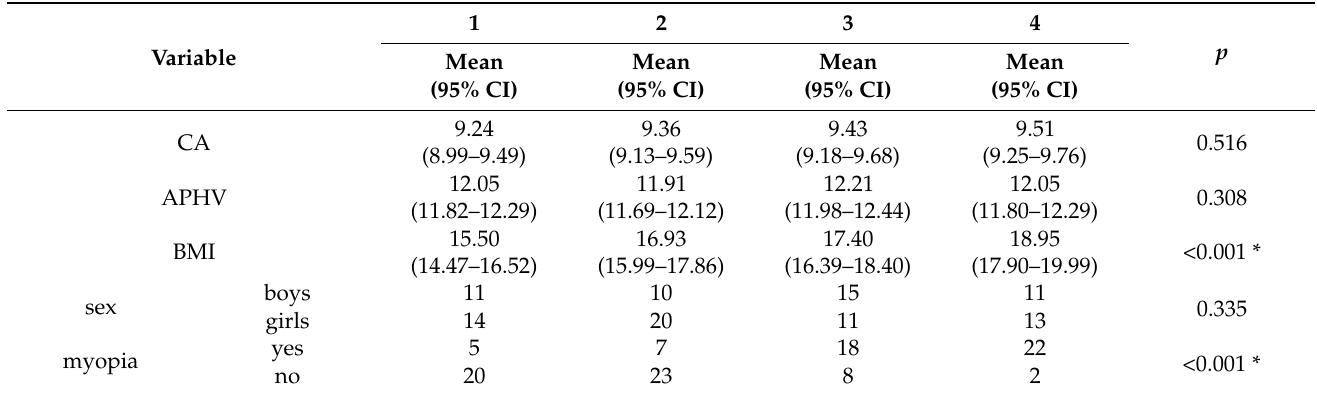
Table 3. Comparison of the clusters regarding age, age at peak height velocity, body mass index, sex, and presence of